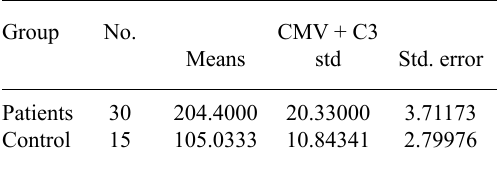
table 3. Mean concentration of C3 in patients and table 4. Mean concentration of C4 in patients